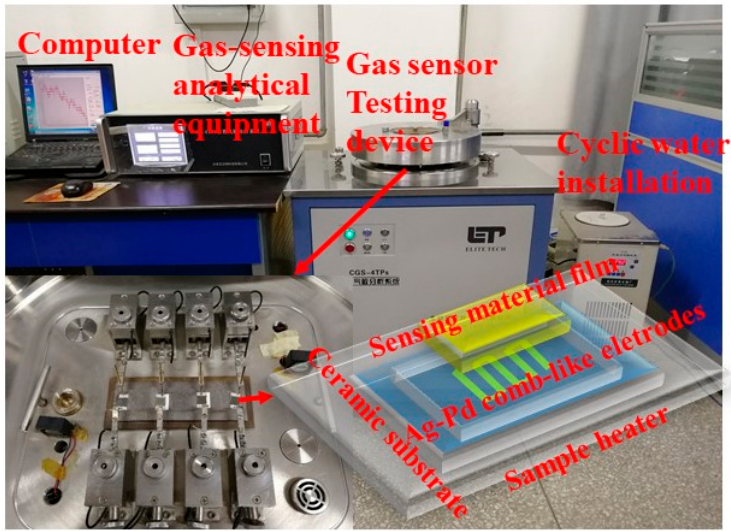
Figure 2. Schematic presentation of the gas sensing analysis system and 3D schematic diagram of the sensor element.